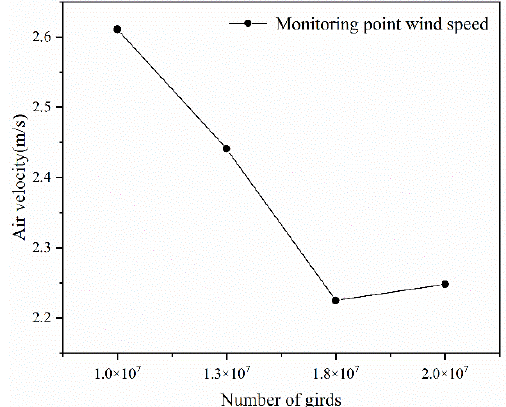
Figure 4. Grid independence analysis assessment.